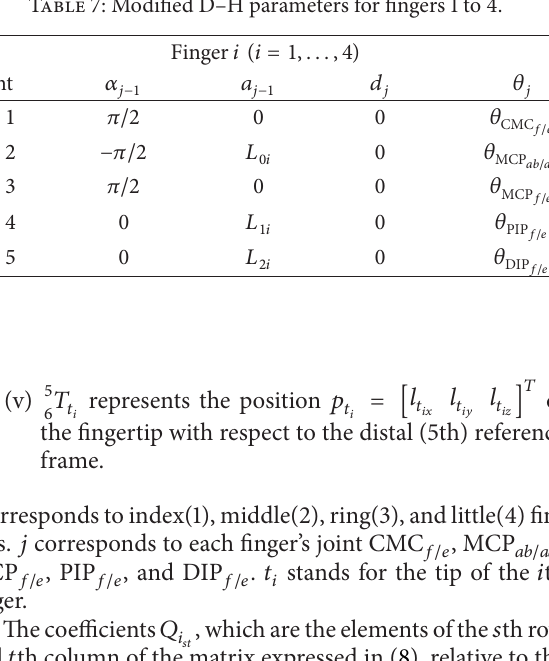
Table 7: Modified D–H parameters for fingers 1 to